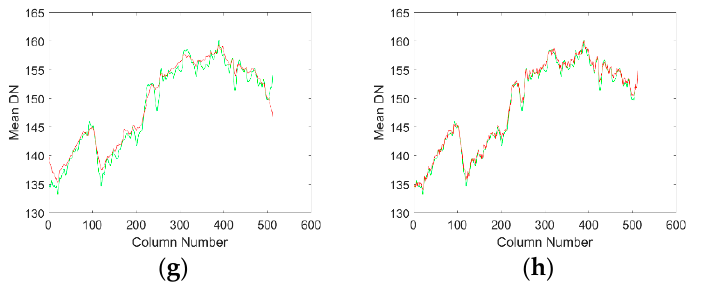
Figure 14. Mean cross-track curves of various denoising results, where the green curve in each result is the mean cross-track curve of the original image, and the red curve is the mean cross-track curve of various denoising results. ( a ) Original image; ( b ) WAFT; ( c ) UTV; ( d ) ASSTV; ( e ) VSNR; ( f ) SILR; ( g ) ℓ (cid:2868) sparse; ( h ) LRSUTV.